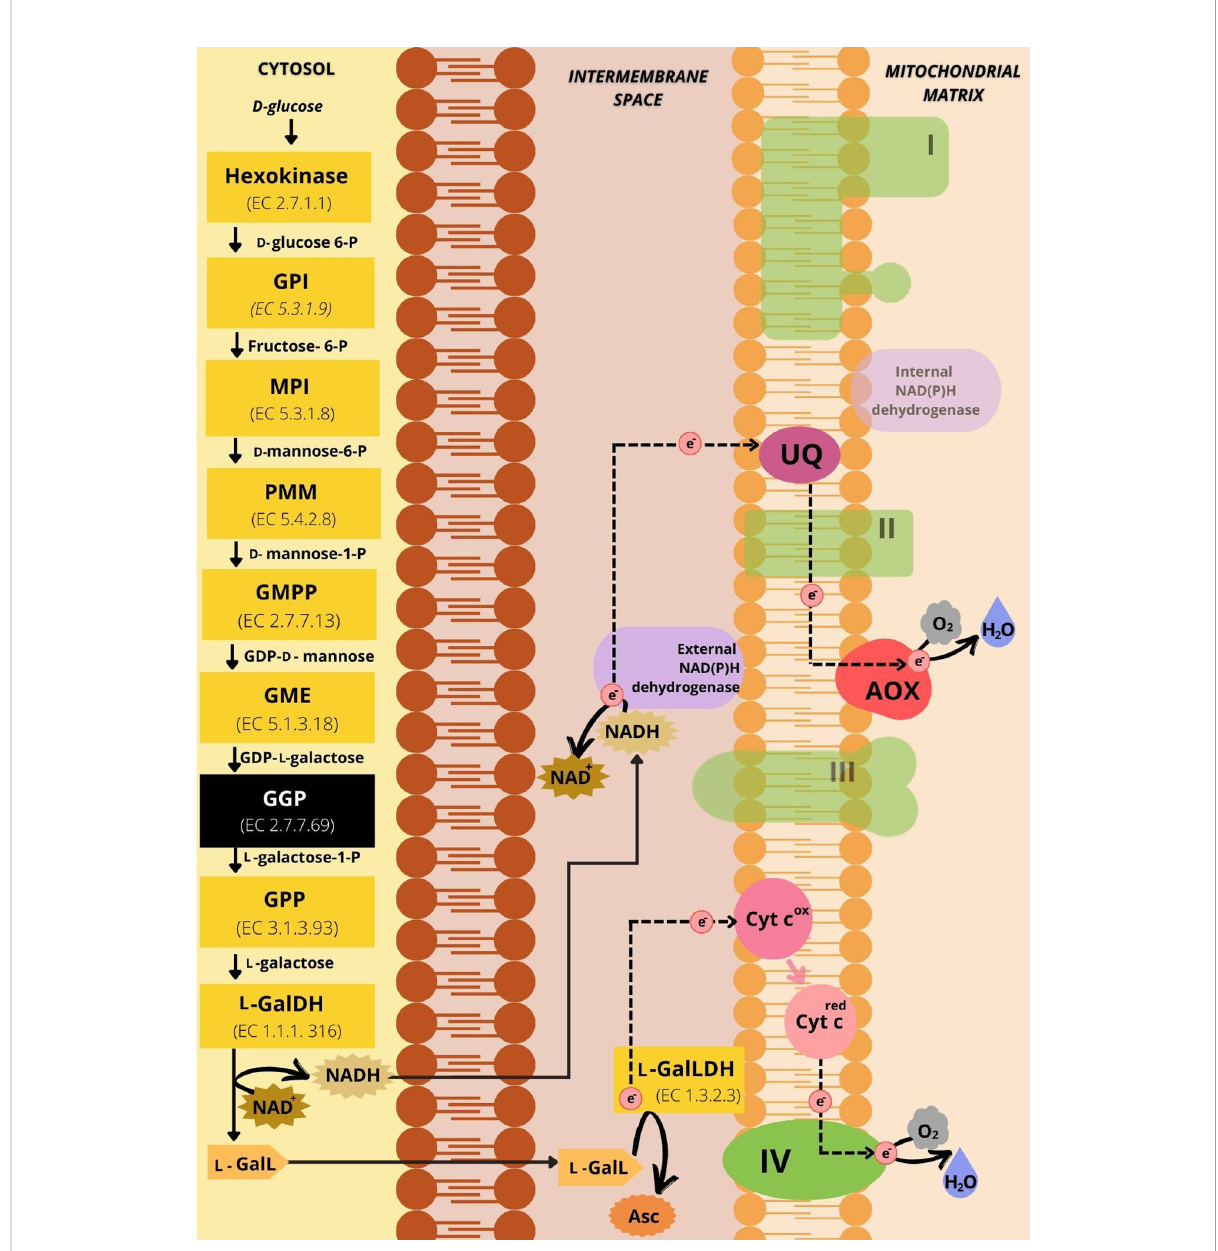
FIGURE 3 Representative scheme of the D -mannose/ L -galactose pathway of ascorbic acid synthesis and its connections with the mETC. The yellow boxes represent the enzymes involved in the 10 steps of the pathway. The black box has the GDP- L -galactose phosphorylase, the enzyme that catalyzes the limiting step for AsA synthesis. The substrates of the enzymatic reactions are described between the boxes. The dotted black arrows represent the path of electrons in the mETC. In green are the respiratory complexes indicated by Roman numerals corresponding to the I-IV Complexes. The shaded green is indicative of respiratory protein components not directly engaged with electron fl ux during the synthesis of ascorbic acid in light. In purple are the alternative NAD(P)H dehydrogenases, highlighting the external NAD(P)H dehydrogenase as the location of the potential regeneration of NAD + . The alternative oxidase is in red and Cytc is in pink. The ubiquinone pool is represented in magenta. NAD + and NADH are represented by spiked outlines. The substrate L -galactone-1,4-lactone ( L -GalL) (in light orange) is oxidized by L -GalLDH using Cytc as the electron acceptor to produce ascorbate (Asc) (in dark orange). GPI: Glucose-6-phosphate isomerase. MPI: Mannose-6-phosphate isomerase. PMM: Phosphomannose mutase. GMPP, GDP-mannose pyrophosphorylase; GME, GDP-mannose-3 ’ -5 ’ - epimerase; GGP, GDP- L -galactose phosphorylase; GPP, L -galactose-1-phosphate phosphatase; L -GalDH, L -galactose dehydrogenase; L -GalLDH, L -galactono-1,4-lactone dehydrogenase; L -GalL, L -Galactono-1,4-lactone; Asc, Ascorbate; NAD + , Nicotinamide adenine dinucleotide oxidized; NADH, Nicotinamide adenine dinucleotide reduced; Cyt c ox , Cytochrome c in oxidated state; Cyt c red , Reduced cytochrome c; AOX, Alternative oxidase; UQ, ubiquinone; I, NADH-ubiquinone oxidoreductase; II, succinate-ubiquinone oxidoreductase; III, ubiquinol-cytochrome c oxidoreductase; IV, cytochrome c oxidase; H + , proton; e - ,